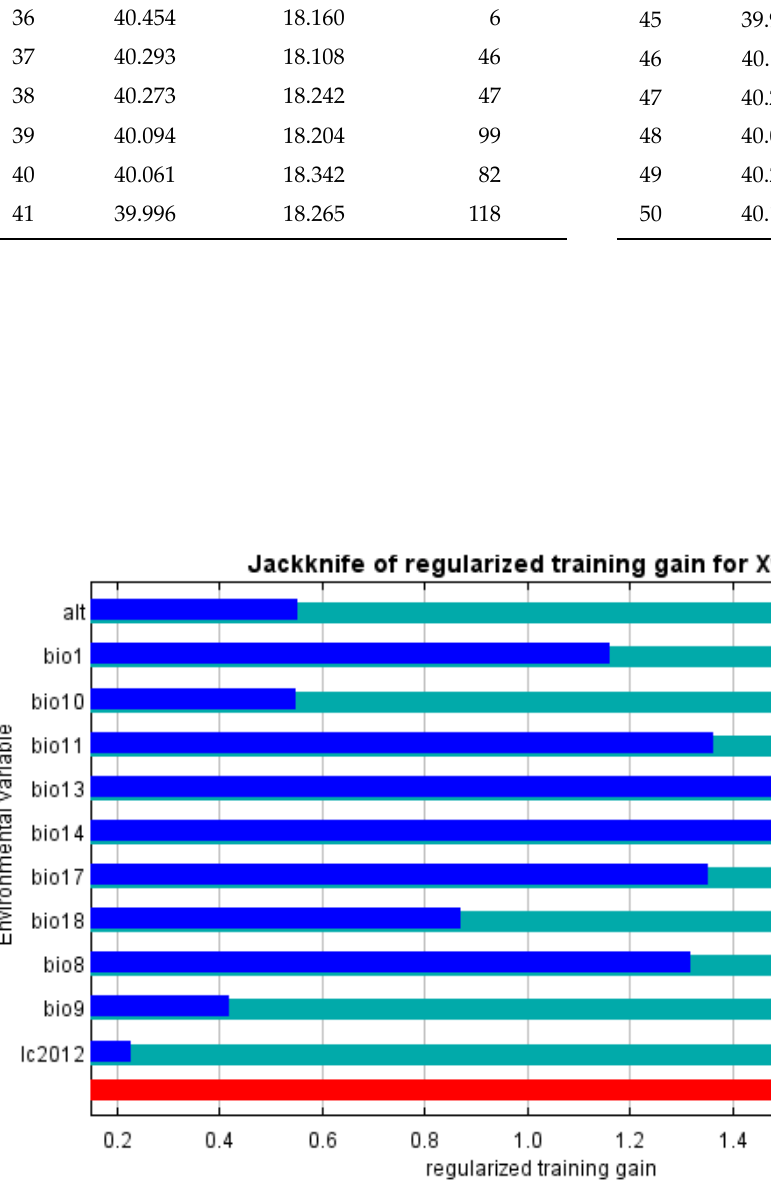
Figure S.1. Jackknife of regularized training gain for X. fastidiosa . The EGVs used for X. fastidiosa models were: Alt = Alti- tude; bio1 = Annual Mean Temperature; bio10 = Mean Temperature of Warmest Quarter; bio11 = Mean Temperature of Coldest Quarter; bio13 = Precipitation of Wettest Month; bio14 = Precipitation of Driest Month; bio17 = Precipitation of Driest Quarter; bio18 = Precipitation of Warmest Quarter; bio8 = Mean Temperature of Wettest Quarter; bio9 = Mean Tem- perature of Driest Quarter; lc2012 = Corine Land Cover